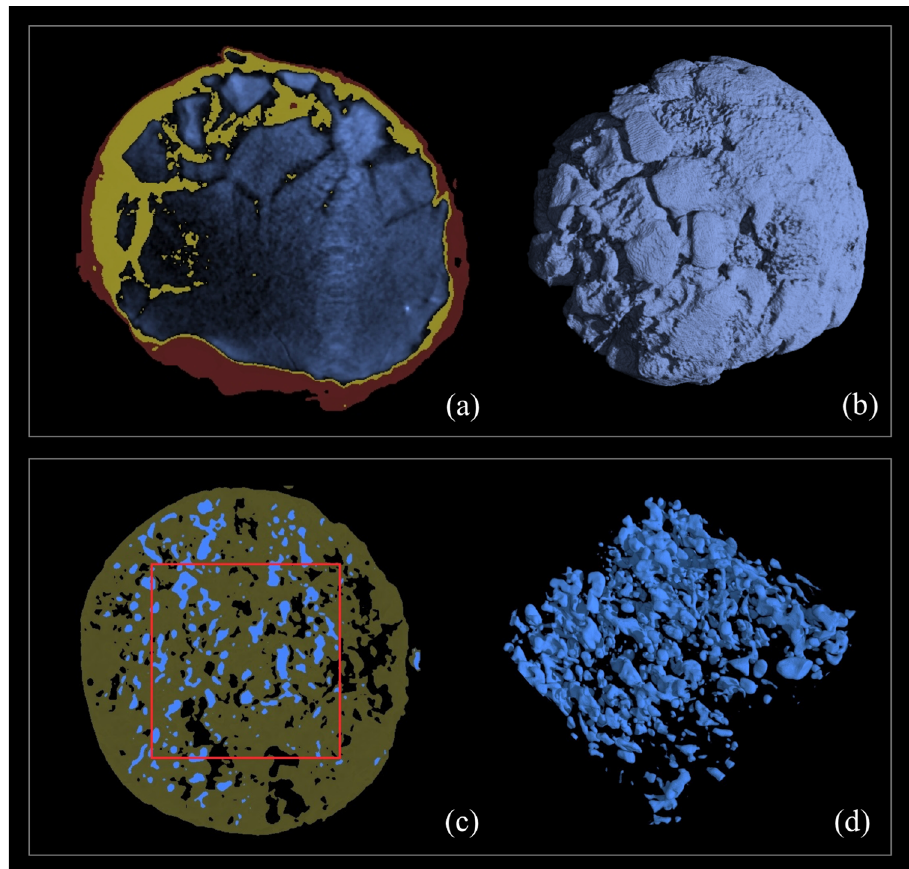
Figure 3. Tomographic volume fractions study of the different materials of inclusions . ( a ) and ( b ) the results of the imaging segmentation of Inclusion #1 where the different materials are shown in red—the patina , yellow— glass, and blue—metal. ( c ) and ( d ) the results of Inclusion #2 with the different materials presented in black— the empty areas, green—glass, and blue—metal (Images: Matteo Bettuzzi, Fauzia Albertin).